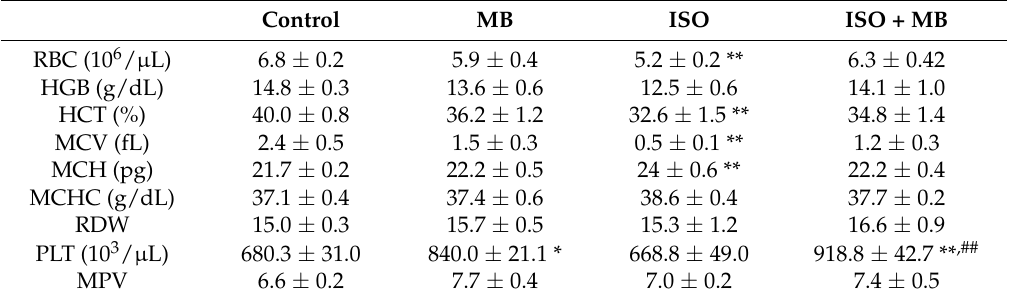
Table 3. Effect of M. bijugatus on red cell and trombocytes parameters in the ISO-induced cardiac injury.